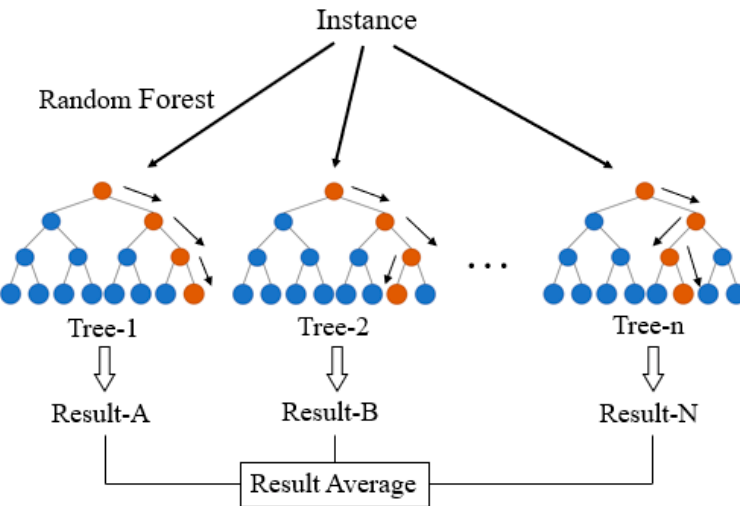
Figure 1 . Schematic diagram of the random forest principle. Figure 1. Schematic diagram of the random forest principle.